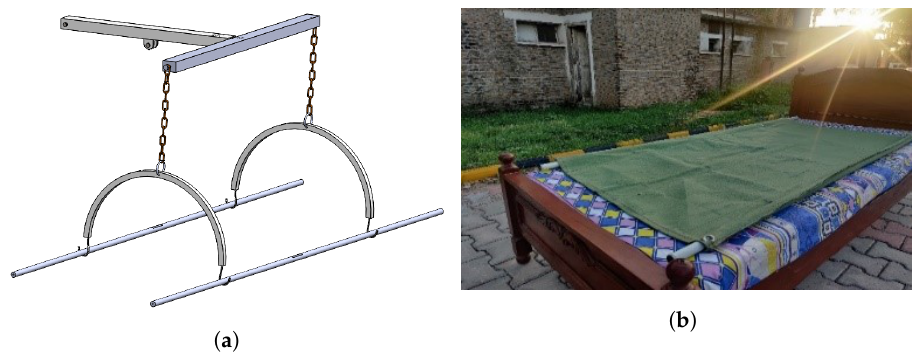
Figure 7. ( a ) Upper frame and ( b ) stretch assembly. Figure 8 shows the dimensions for U bar and stretcher